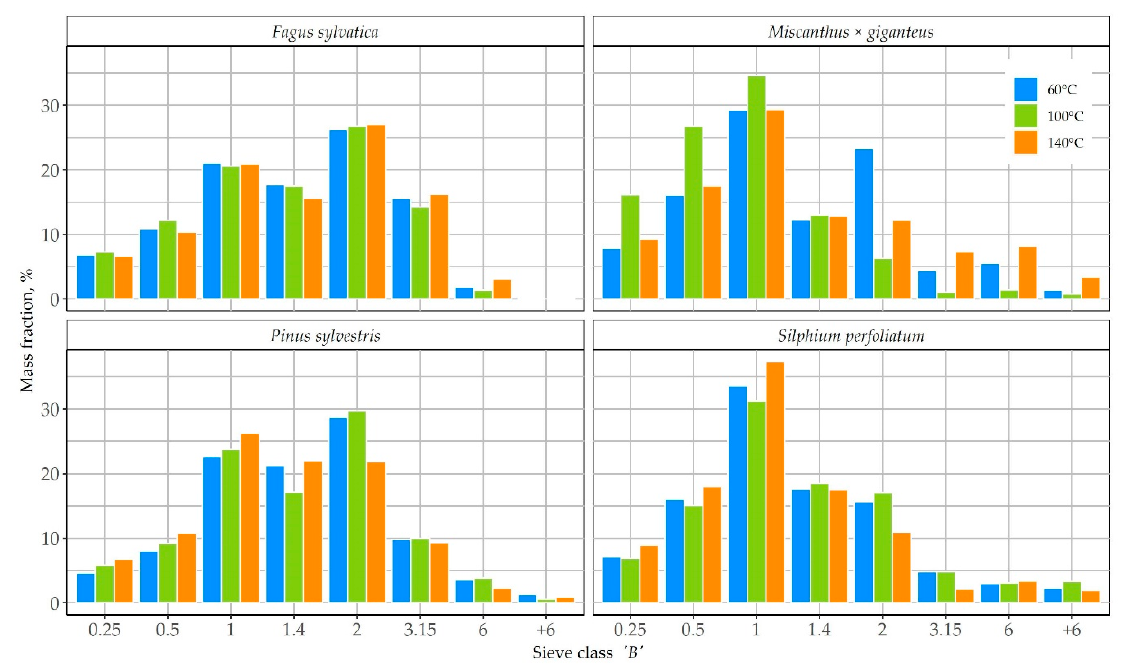
Figure 1. The samples’ particle size distribution after the preliminary grinding stage.